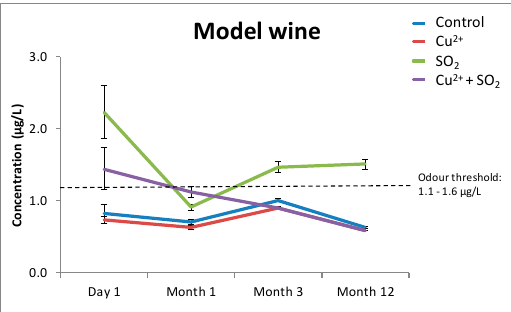
Figure 2. The effects of Cu 2+ , SO 2 , and “Cu 2+ + SO 2 ” on the concentration of H 2 S in a model wine matrix that did not contain any wine compounds, such as polyphenols or tannins, that could modulate the formation of H 2 S. The odor threshold of H 2 S (1.1–1.6 µ g/L [28]) is indicated with the dashed line parallel to the x -axis. Samples were stored under nitrogen (N 2 ) and measured over the course of 12 months.